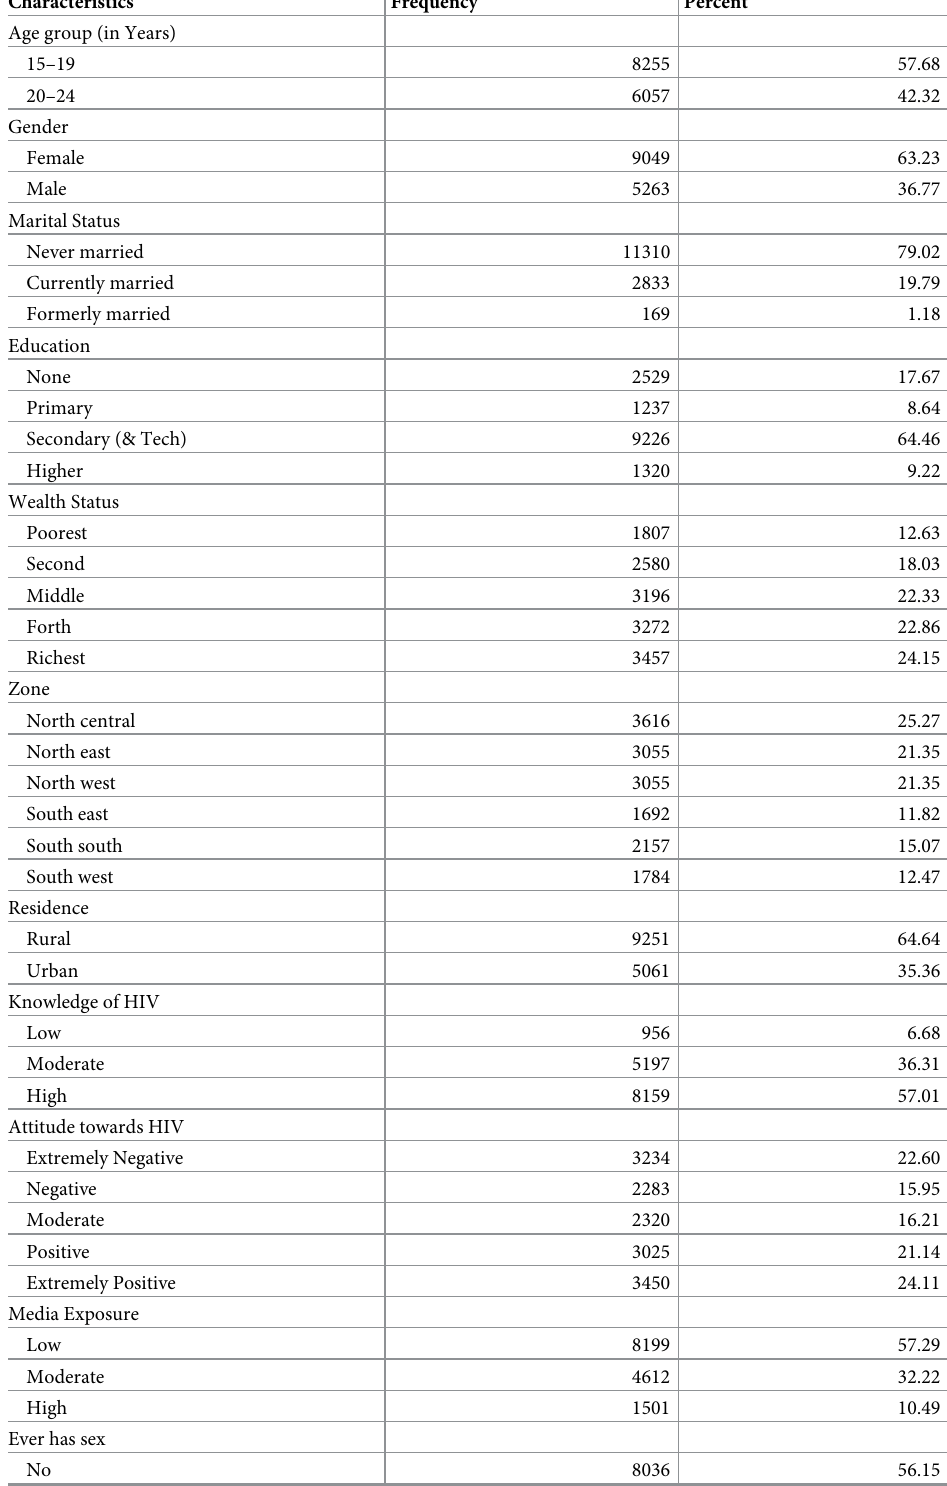
Table 1. Weighted sociodemographic, contextual and behavioural characteristics of study